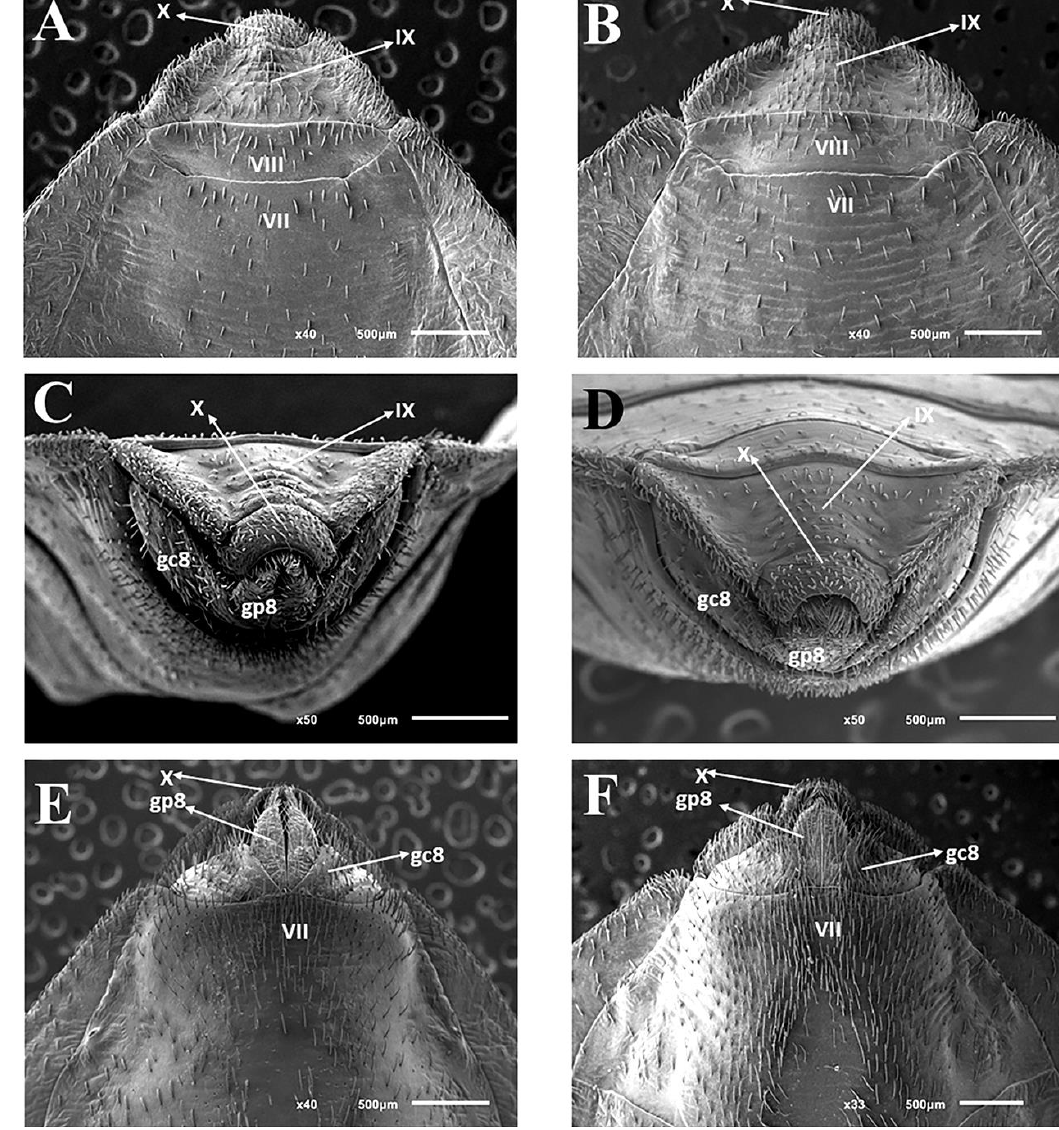
Figure 5. Female external genitalia by SEM: T. rosai sp. nov. ( A ) dorsal view, ( C ) posterior view, ( E ) ventral view, T. sordida : ( B ) dorsal view, ( D ) posterior view, ( F ) ventral view. Gc 8: gonocoxite; Gc 9: gonapophyse; Gp 8: gonapophyse, VII, VIII, IX: tergites; X: segment. Posterior view of female external genitalia: the central part of the region that divides the eighth and ninth segments is straight; the junction of the ninth segment Ⅸ with the central portion is convex. Being elevated, the lateral portions (1 + 1) form depressions in the anteroposterior direction (Figure 5B). The boundaries between the ninth and tenth segments are opened on the sides and closed in the central area (Figure 5B). The tenth segment is semicircular (Figure 5B). Gonocoxites 8 are penniform, while gonapophyses 8 are almost triangular (Figure 5B).